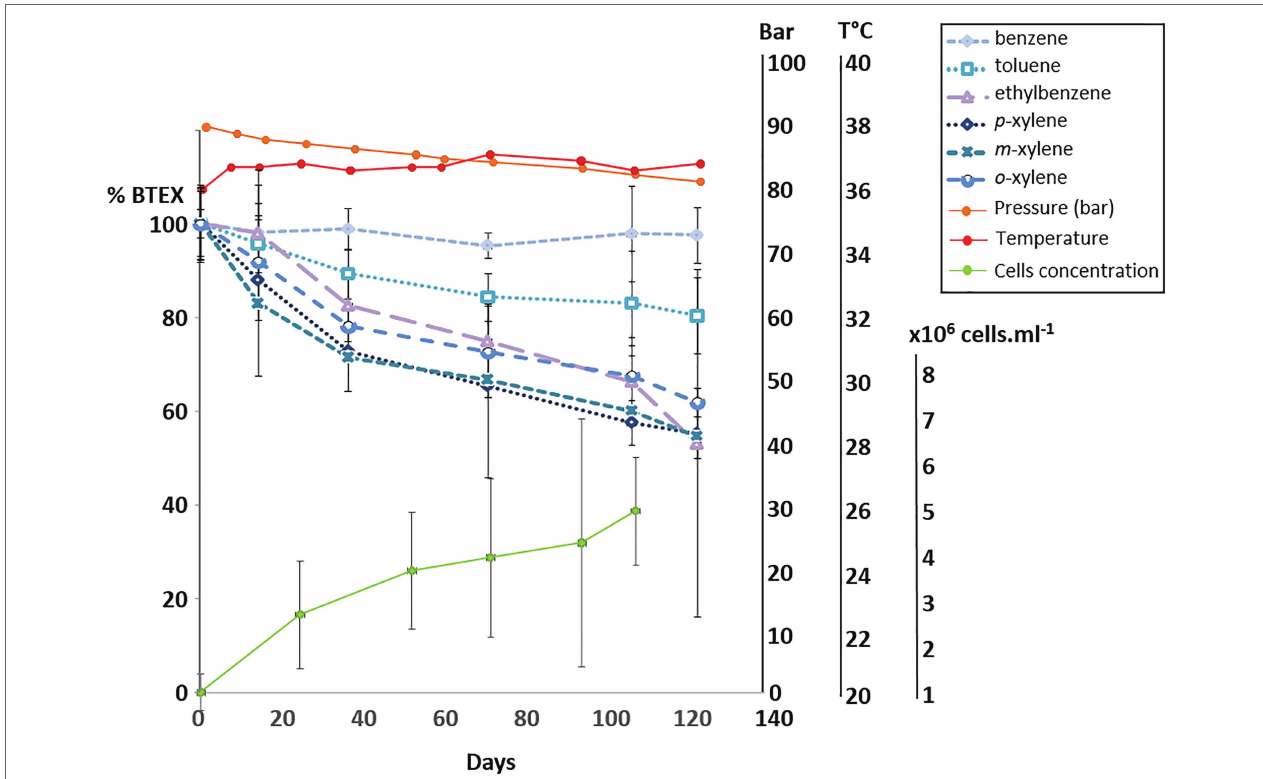
FIGURE 3 | Degradation of BTEX by the bacterial community at 90 bar with monitoring of the cell concentration by microscopic